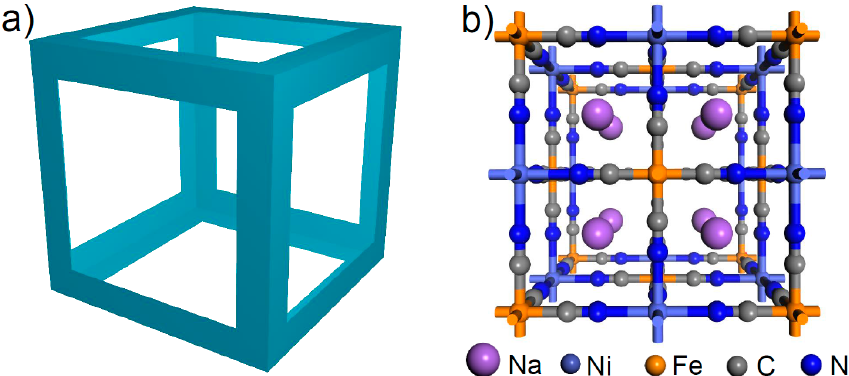
Figure 1. ( a ) Scheme for Prussian Blue analogue mesoframe. ( b ) Schematic crystal structure for Prussian Blue analogue.